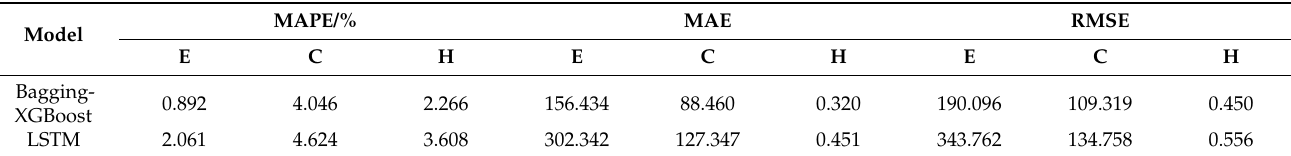
Table 6. Comparison of Bagging-XGBoost model and LSTM model indicators.